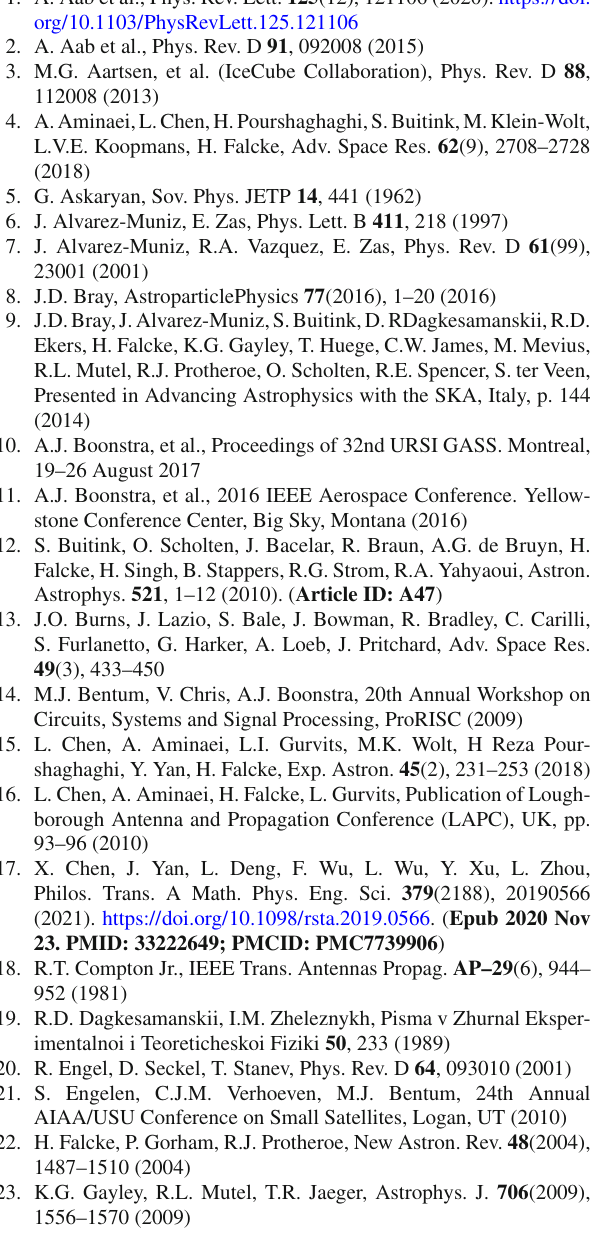
Fig. 11 Angular aperture ΔΩ CR for the cosmic ray detection with a lunar orbital ULW radio antenna at different altitudes of 50, 100 and 200km, and for the initial cosmic ray energy W = 10 21